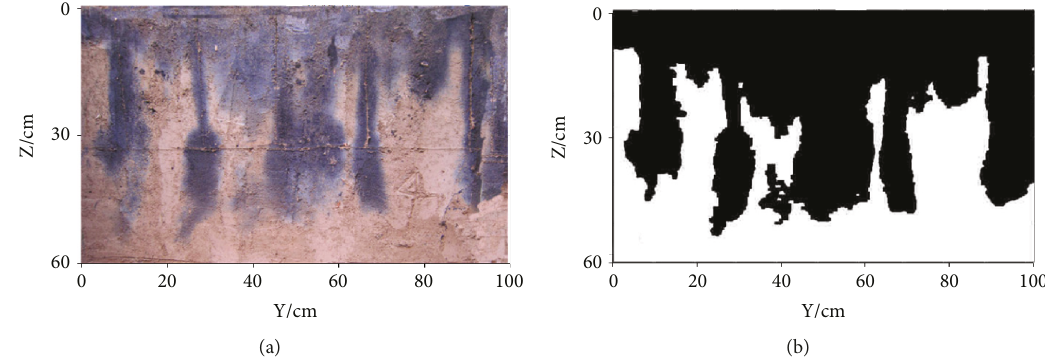
Figure 2: Heterogeneous dye coverage patterns at experiment plot before (a) and after (b) image